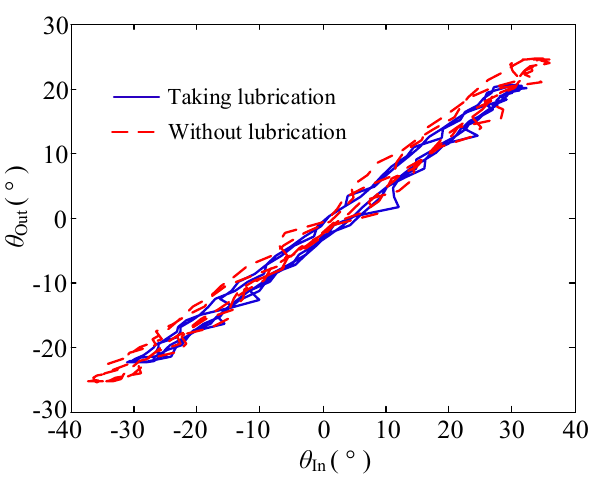
Figure 6. Displacement transfer relationship when the lubrication condition changes.